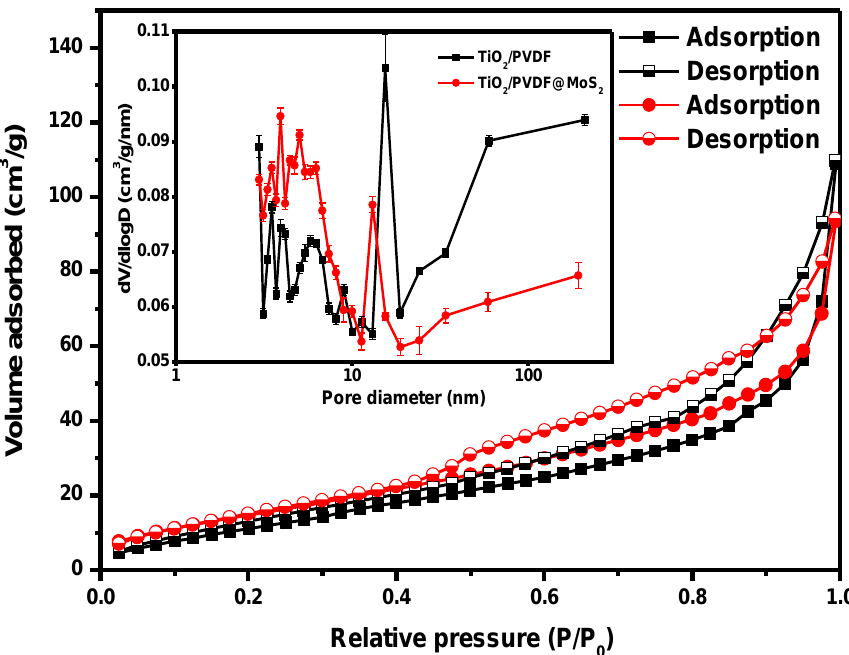
Figure 6. Nitrogen adsorption – desorption isotherms and the corresponding pore-diameter distribution curves (inset) of TiO 2 /PVDF (Black line) and TiO 2 /PVDF@MoS 2 core-shell heterostructured fibers (Red line).